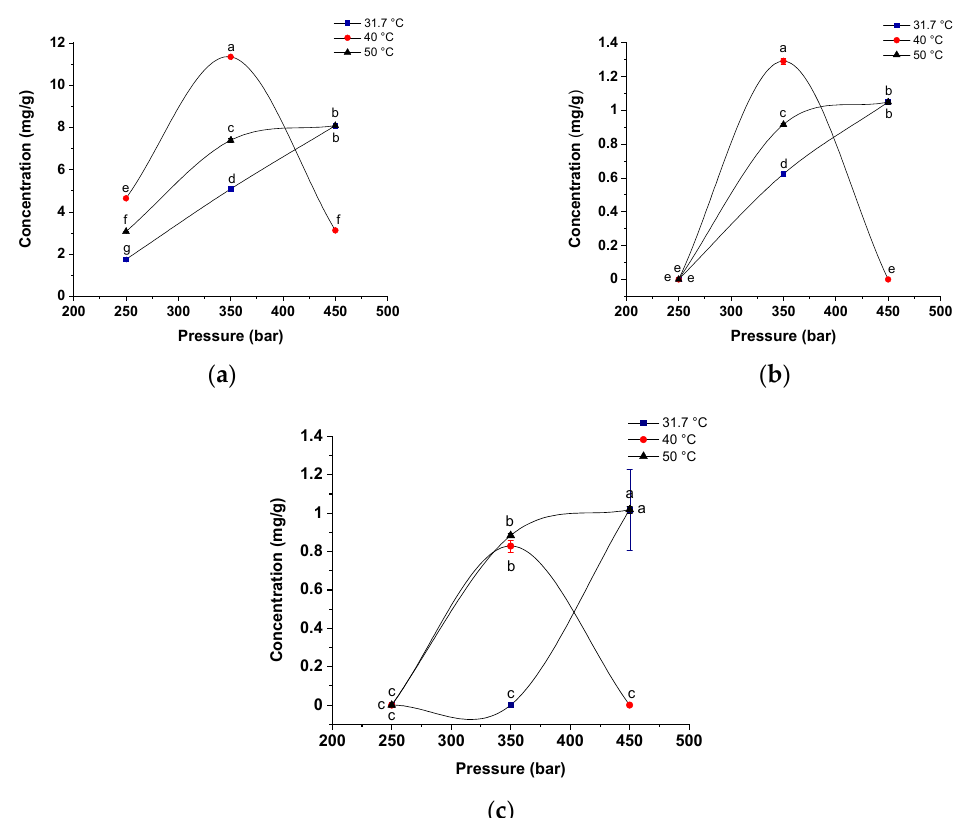
Figure 5. Isotherms for the concentration of: ( a ) formononetin; ( b ) naringenin; and ( c ) kaempferol for the extraction of red propolis using CO 2 as the supercritical fluid, ethanol as the cosolvent (4%, w/w ) at temperatures of 31.7, 40 and 50 °C and pressures of 250, 350 and 450 bar (CO 2 flow rate of 6 g/min and S/F 131). Values that show the same letter in the same graph are not significantly different ( p < 0.05) by the Tukey test at a confidence level of 95%.